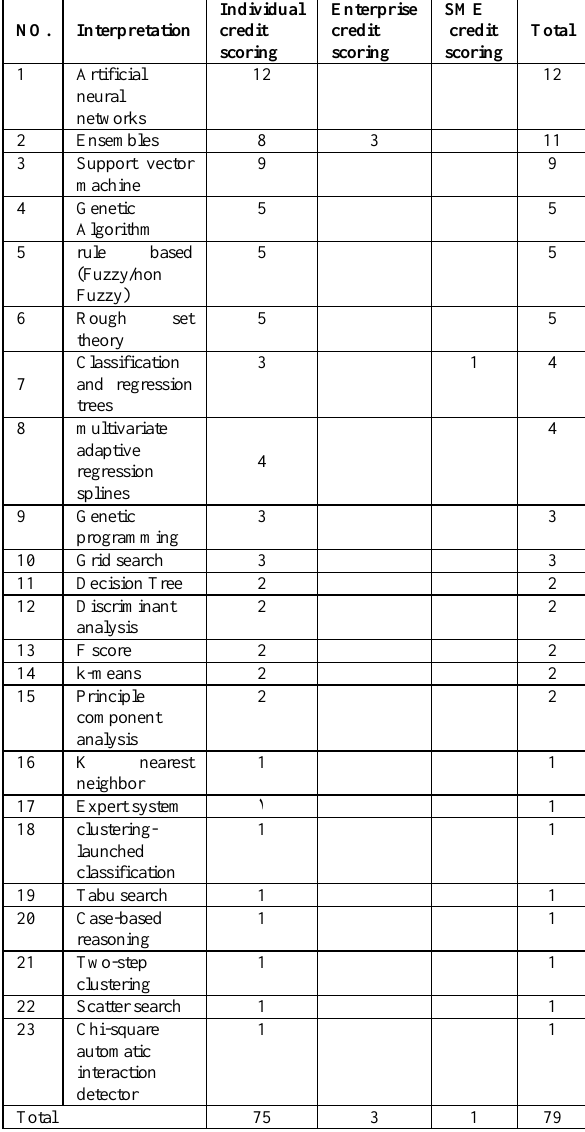
Table 3. Statistics of articles on credit Scoring and data mining techniques.